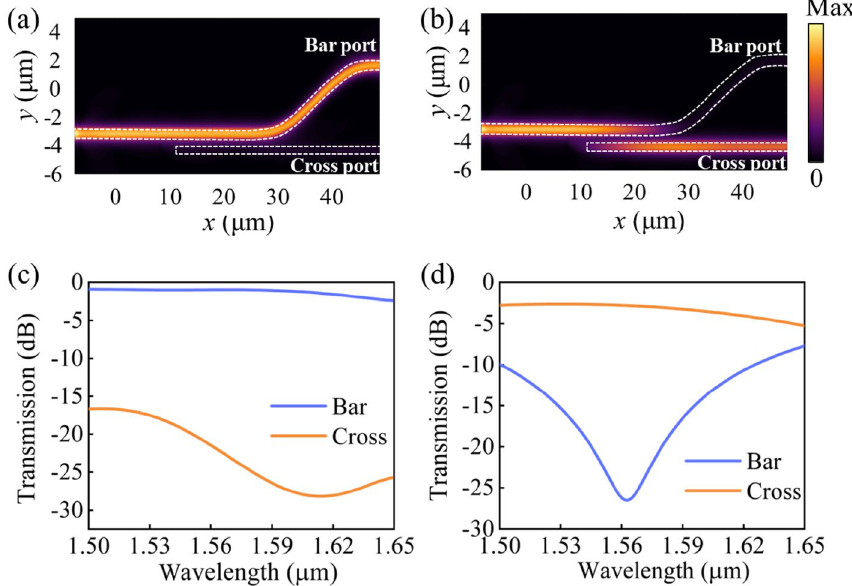
Figure 6. The normalized field intensity distribution along the propagation direction in the pump-off state ( a ) and pump-on state ( b ). Transmission spectra in the Cross port and Bar port in the pump-off state ( c ) and pump-on state ( d ).